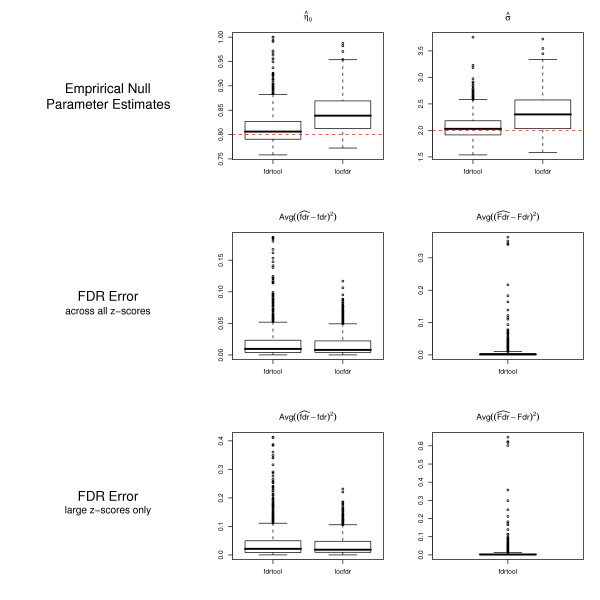
Accuracy and variability of estimates of the null proportion η0 and the scale parameter s as well as the squared error of Fdr and fdr for z-score based algorithms. As in Fig. 5 m = 200 and B = 1000 was used. For the plots in the third row only z-scores with |z| > 2 were used.